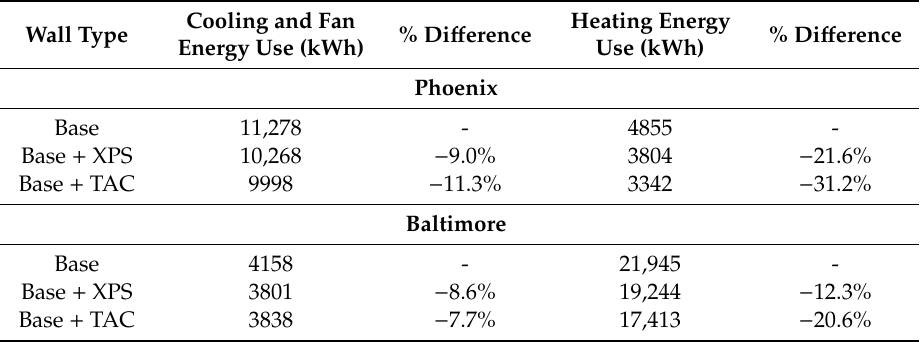
Table 5. Comparison of calculated annual whole building cooling and heating-related energy use and percent di ff erence with respect to the “Base”